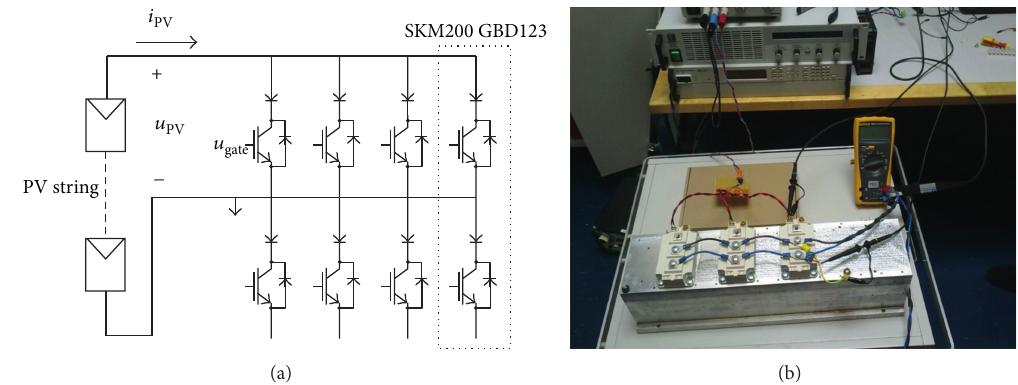
Figure 6: (a) Scheme of the I-U curve measurement tracer for PV power systems. (b) Picture of the IGBT modules, cooler and power measuring connections.